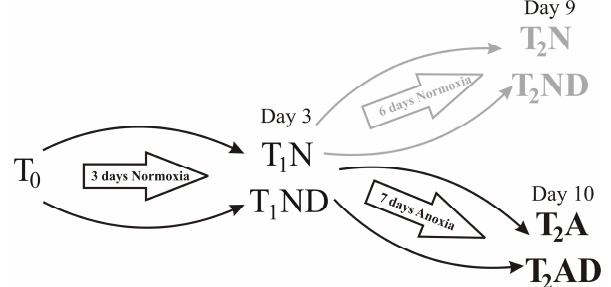
Fig. 2. Experimental design: T 0 : start of the experiment; T 1 : 3 days; Figure 2. Experimental design: T 0 : start of the experiment, T 1 : 3 days, T 2 : after 6 or 7 days 4 T 2 : after 6 or 7 days (i.e. 9 or 10 days in total); N: Normoxia; A: (i.e. 9 or 10 days in total), N: Normoxia, A: Anoxia, D: Diatoms added 5 Anoxia; D: Diatoms